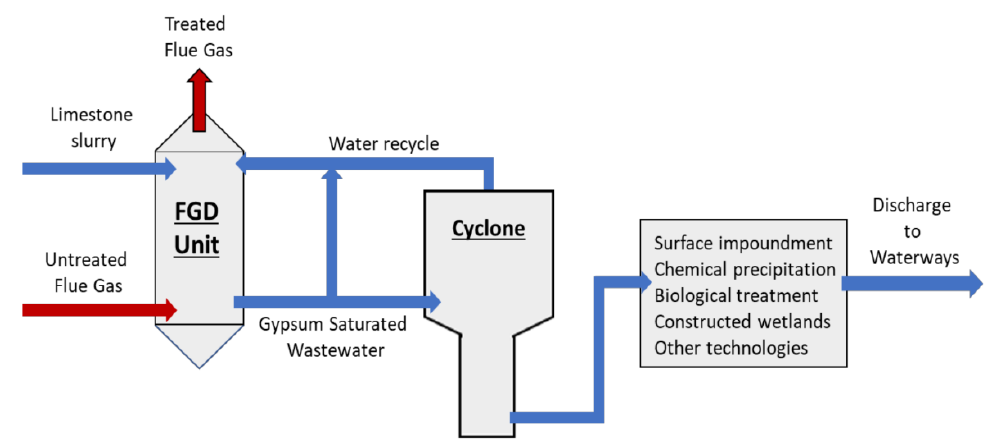
Figure 1. Simplified FGD WW treatment process. Gypsum-saturated WW exits the FGD unit and typically goes through a cyclone or settling process, followed by one or more treatment processes to remove pollutants. The treated FGD WW is eventually discharge to the environment.